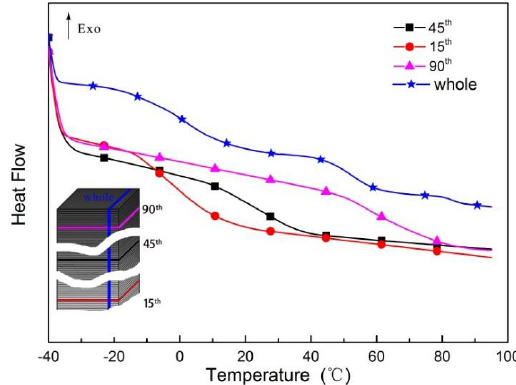
Figure 5. Differential scanning calorimetry (DSC) analysis of the slices selected from the gradient IPN. Temperature sweeps from −40 to 95 °C at a slope of 15 °C/min in nitrogen atmosphere (50 mL/min).